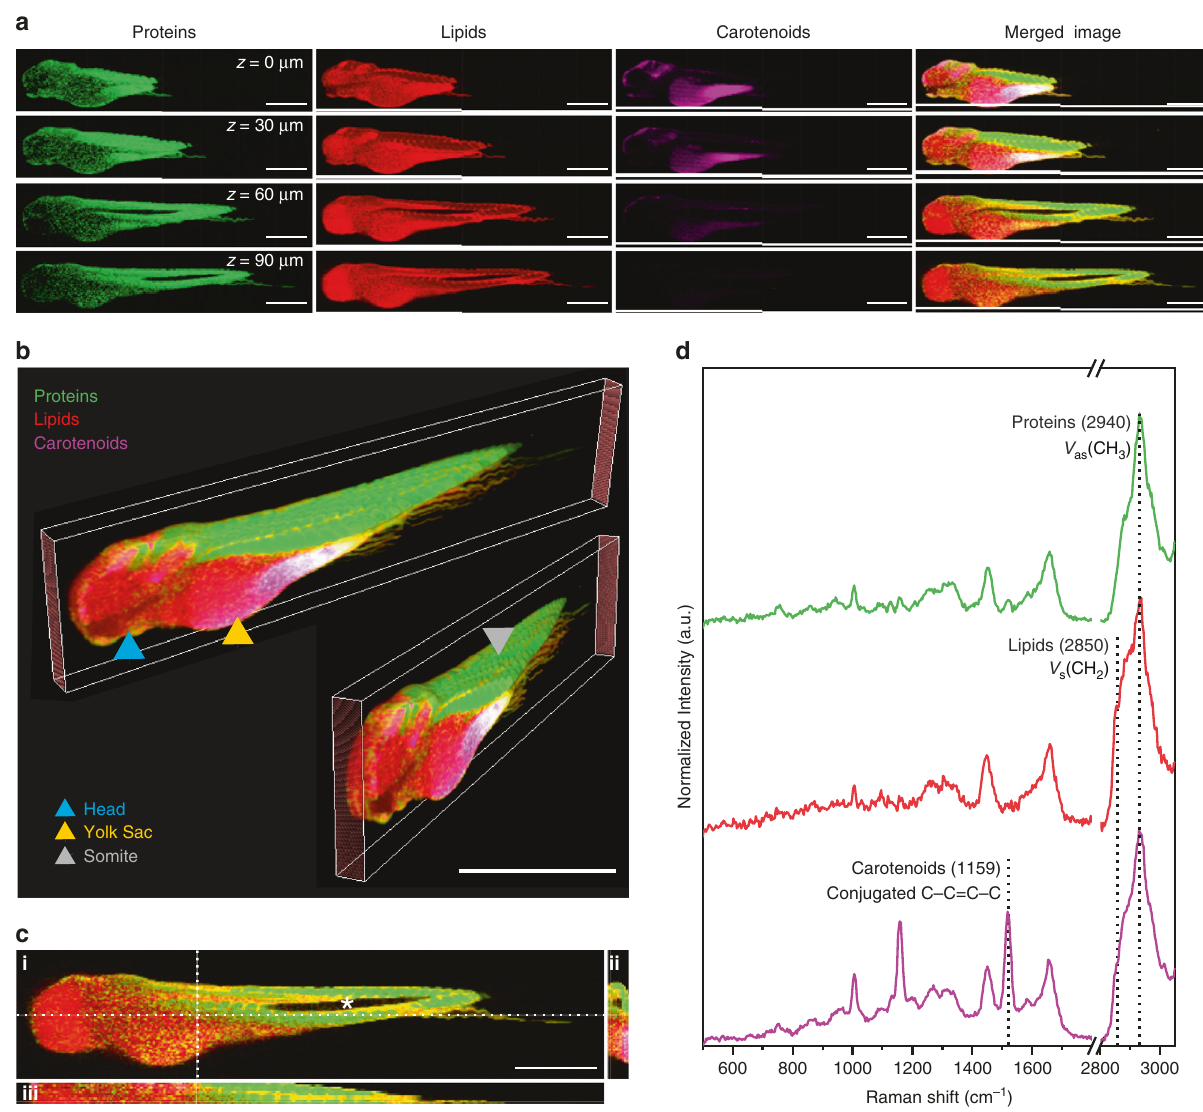
Fig. 2 Volumetric confocal Raman spectroscopic imaging of whole zebra fi sh embryos. Confocal Raman spectroscopic imaging (cRSI) was used to image a fi xed embryo ( N = 1) at 3 days post fertilization at 10 μ m in-plane resolution and 10 μ m out-of-plane resolution. a Single images collected at different confocal planes with normalized univariate peak intensity (a full dataset with all confocal planes is shown in Supplementary Fig. 1). The Z-position relative to the top slice of the stack is indicated. Scale bars: 500 μ m. b These individual confocal planes were reconstructed into a multichannel 3D stack with 10 x 10 x 10 µ m 3 voxel resolution, enabling whole-embryo visualization at different angles. The blue triangle indicates the head, the orange triangle indicates the yolk sac, and the grey triangle indicates a somite. Scale bar: 1 mm. c Z -projections were also generated enabling cross-sectional visualization of (i) the sagittal plane, (ii) the frontal plane and (iii) the transverse plane. The asterisk in the sagittal plane denotes the hollow notochord, which can also be visualized as a cross-section in the transverse plane images. Scale bar: 500 µ m. d Representative spectra collected from volumetric cRSI performed on whole zebra fi sh embryos. The annotated peak centers used for univariate analysis are indicated by dotted lines. Univariate analysis was performed by integrating over a wavenumber range corresponding to relevant biomolecules: protein-rich regions at 2940 ± 16 cm − 1 (shown in green), lipid-rich regions at 2850 ± 5 cm − 1 (shown in red), carotenoid-rich regions at 1159 ± 16 cm − 1 (shown in